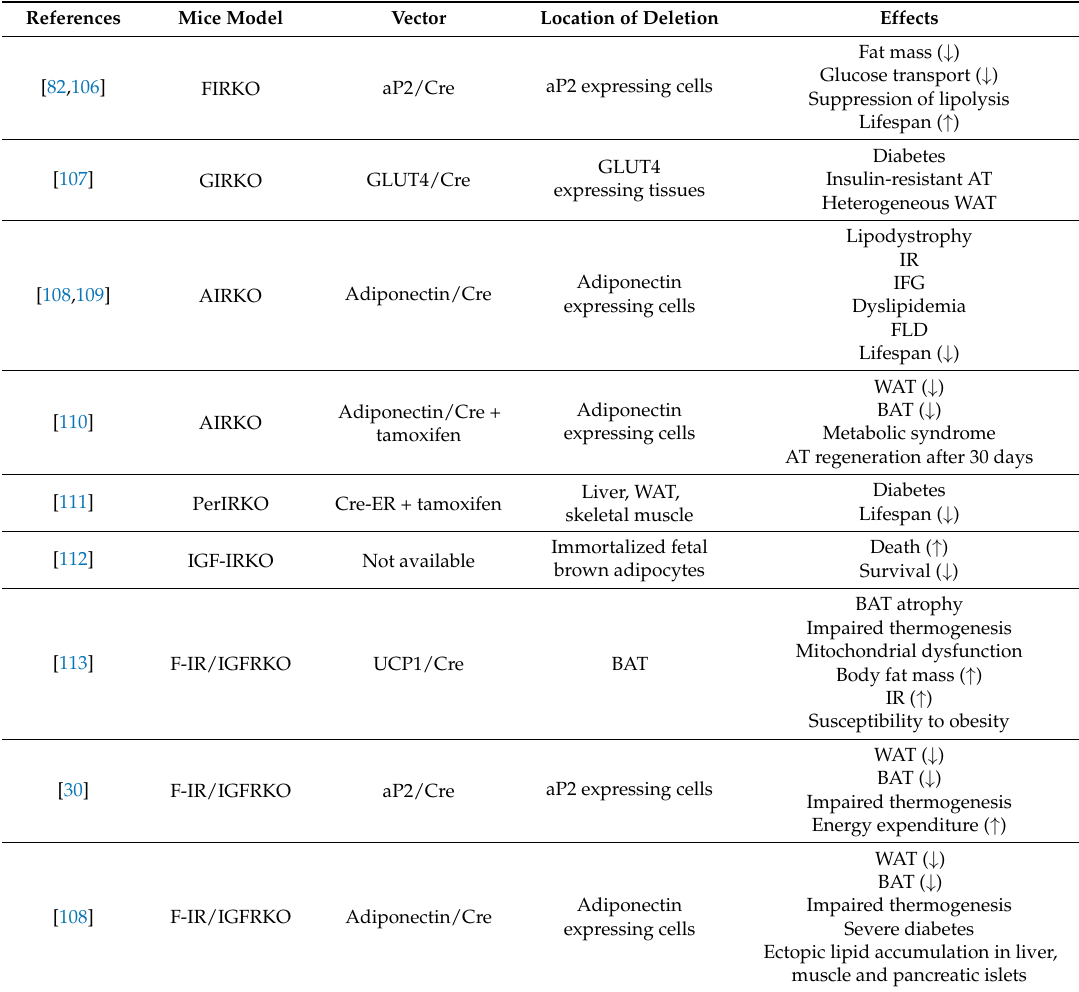
Table 2. In vivo effects of insulin receptor (INSR) and insulin-like growth factor-I receptor (IGF-IR) deletion in